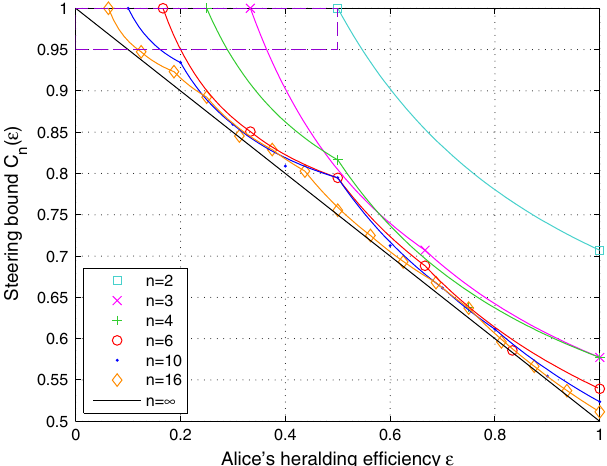
FIG. 3. Loss-dependent EPR-steering bounds. The solid curves are the theoretical bounds C n ð (cid:2) Þ on S n for demonstrating EPR- steering with no detection loophole, for n ¼ 2 , 3, 4, 6, 10, 16, and 1 . The same-colored symbols (some of which do not lie on the curves) correspond to the steering parameter S n which is theoreti- cally obtainable by a cheating Alice using a deterministic strategy (see text). The dashed purple box is shown in detail in Fig.